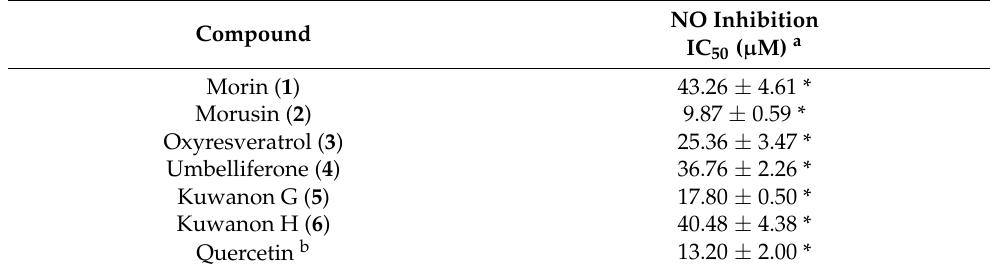
Table 8. Effects of the isolated components on nitric oxide (NO) production in RAW 264.7